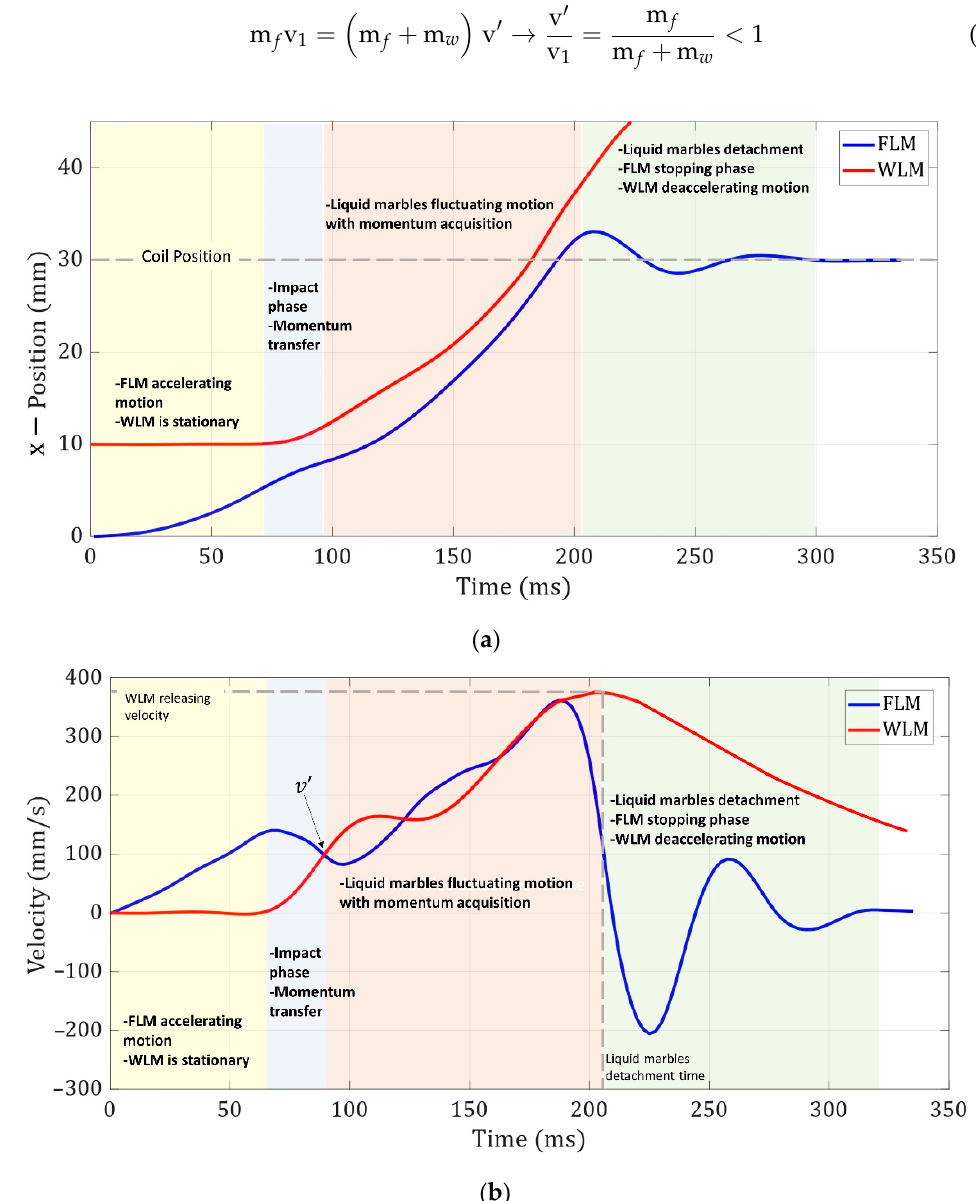
Figure 5. ( a ) Position and ( b ) velocity of FLM and WLM versus time for liquid marble volumes of 30 μ L, coil current of 3 A, and FLM and WLM initial distances of 30 mm and 10 mm from the electromagnet, respectively.